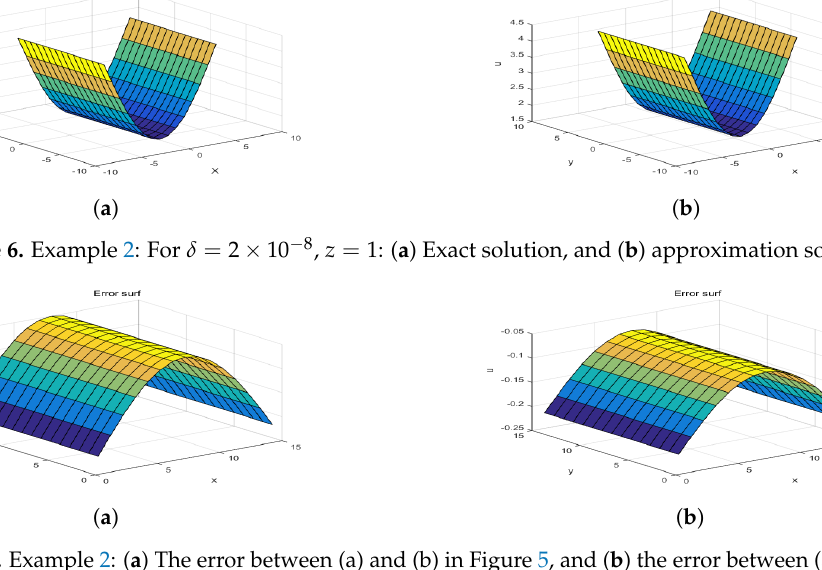
Figure 7. Example 2: ( a ) The error between (a) and (b) in Figure 5, and ( b ) the error between (a) and (b) in Figure